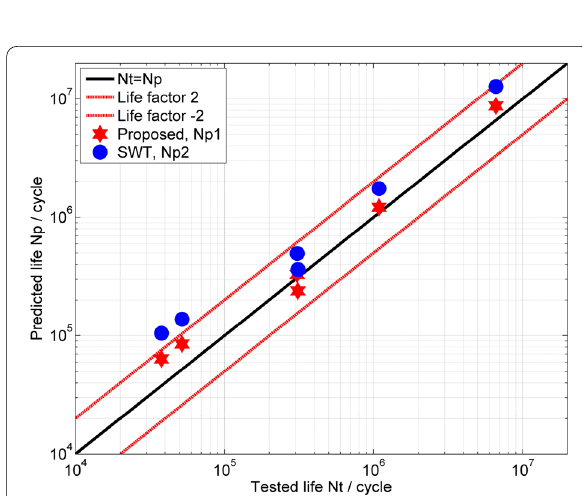
Figure 11 Predicted lives vs. tested lives of GCr15 at torsion test